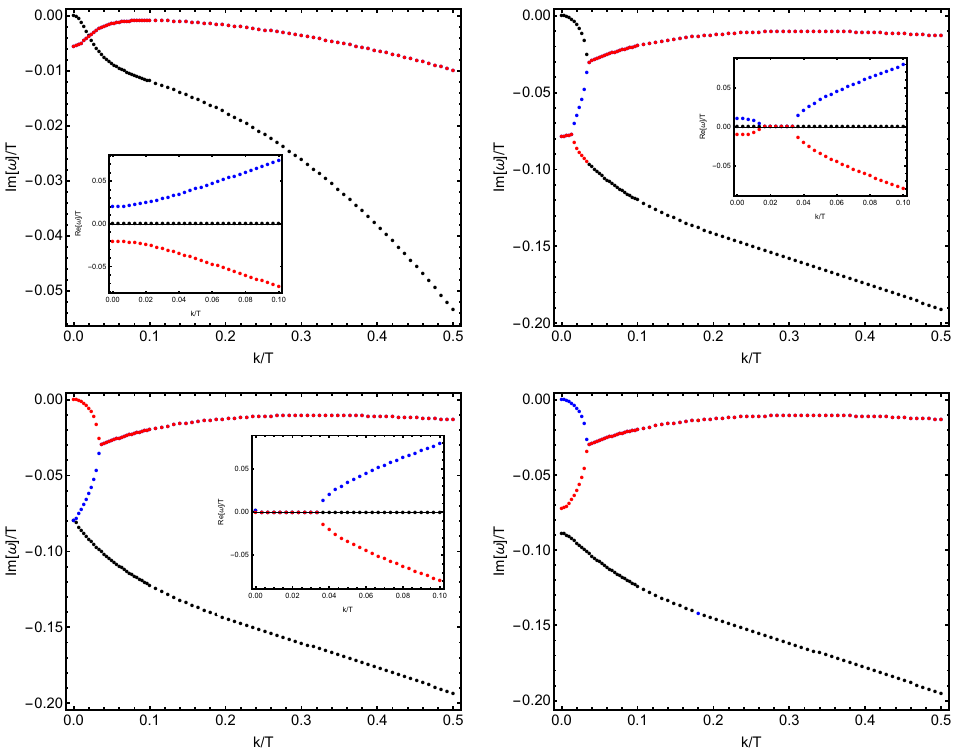
Figure 24 . The lowest modes in the longitudinal sector of the solid model V ( X ) = (cid:11)X + (cid:12)X 5 for (cid:12) = 5 ; m=T = 0 : 1 and (cid:11) 2 [0 : 0005 ; 0 : 0412] (from top to